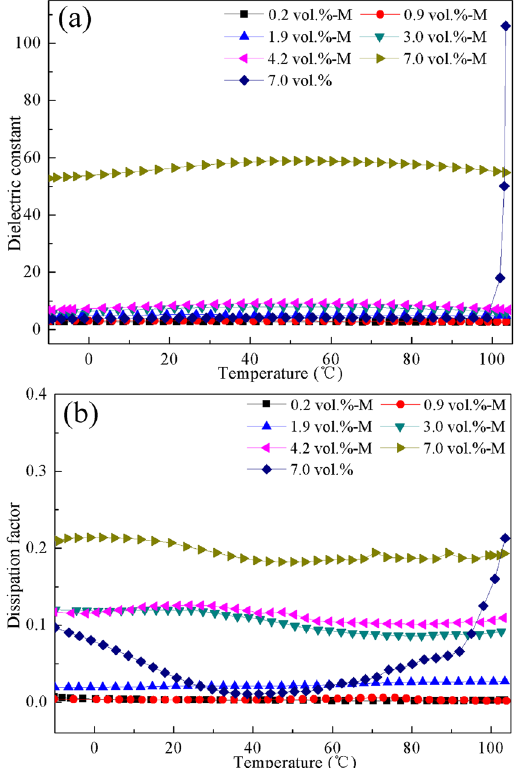
Figure 7. Temperature dependence of ( a ) dielectric constant and ( b ) dissipation factor of the Fe 3 O 4 /LDPE and M-Fe 3 O 4 /LDPE composites at different volume fraction of Fe 3 O 4 filler at 10